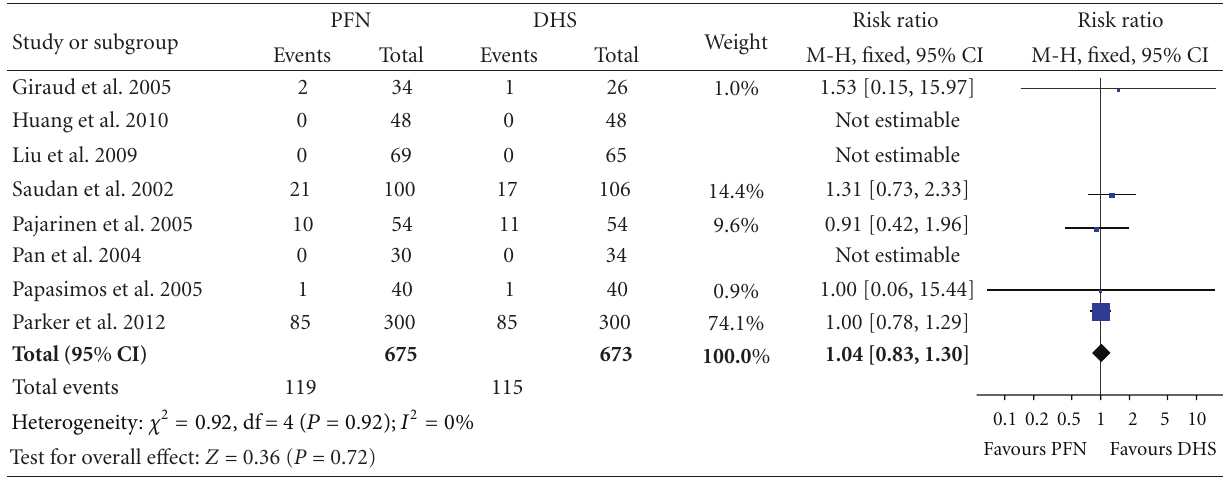
Figure 7: Comparison of mortality between PFN and DHS.